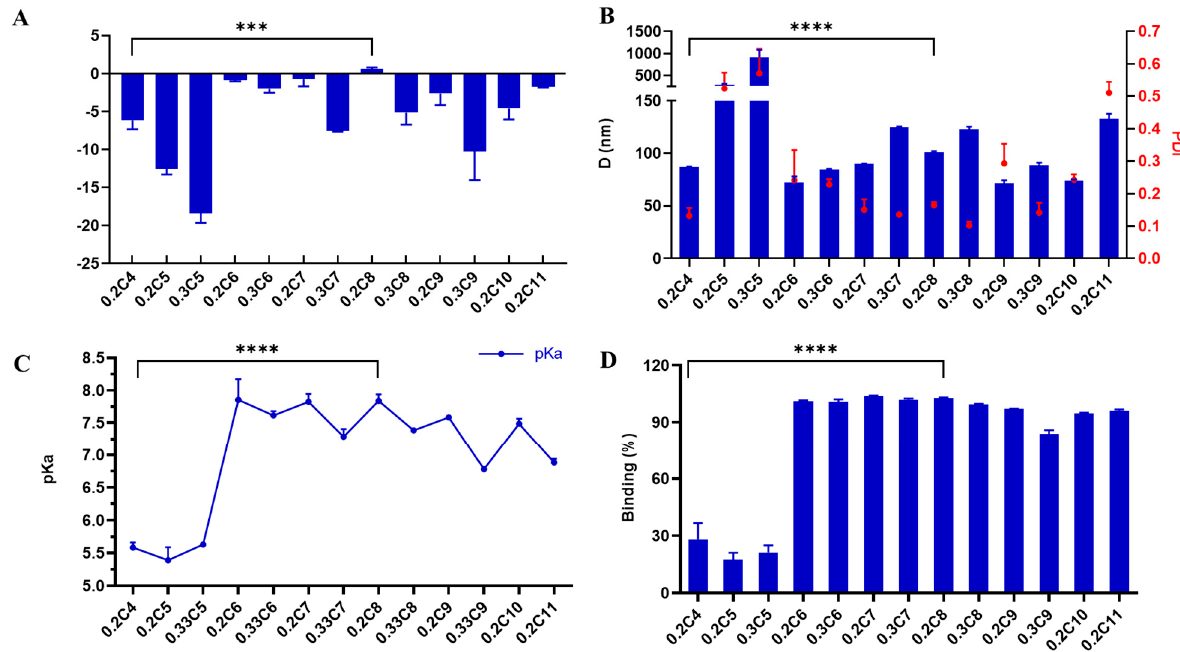
Figure 4. Physicochemical properties of mRNA polyplex nanoparticles with selected functional polyesters (PE4K–A17): ( A ) surface charge; ( B ) PDI and size; ( C ) pKa; ( D ) RNA binding (mean ± s.d., n = 3, p < 0.001 (***) and p < 0.0001 (****)).